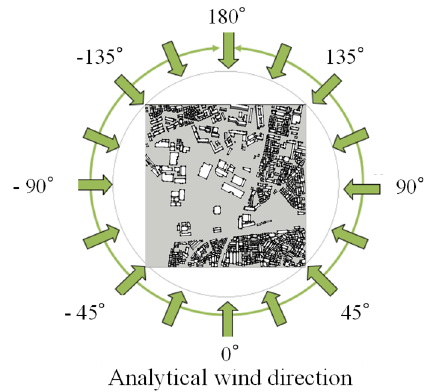
Figure 5. Analysis of cases for wind pressure coefficients for 16 wind directions. 155